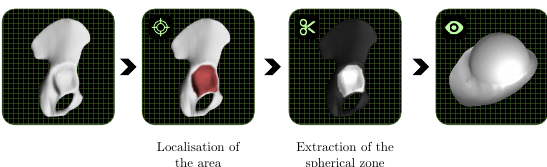
Figure 5. CAD creation of hip cup.